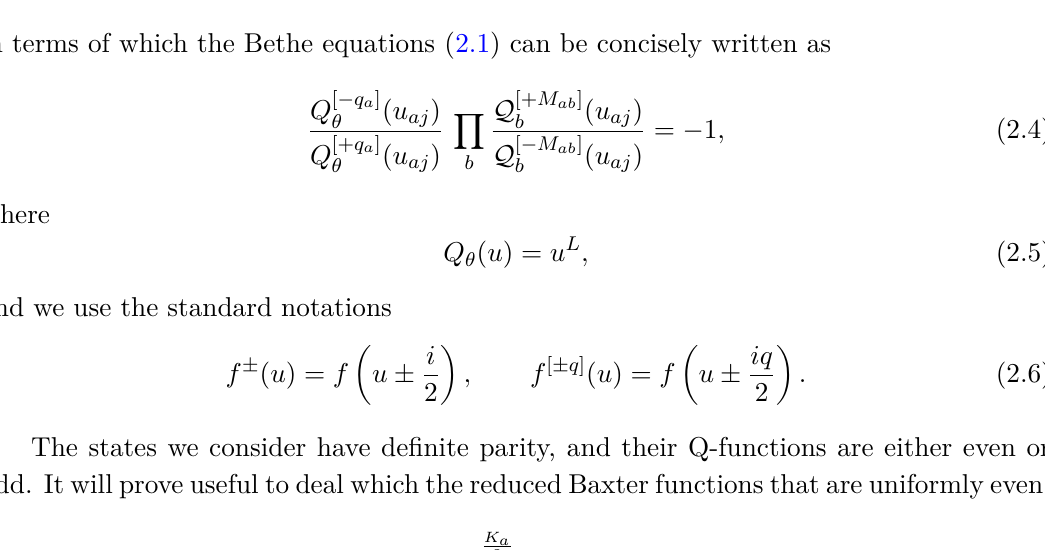
Figure 1 . A graphic notation for the pre-factor in the overlap